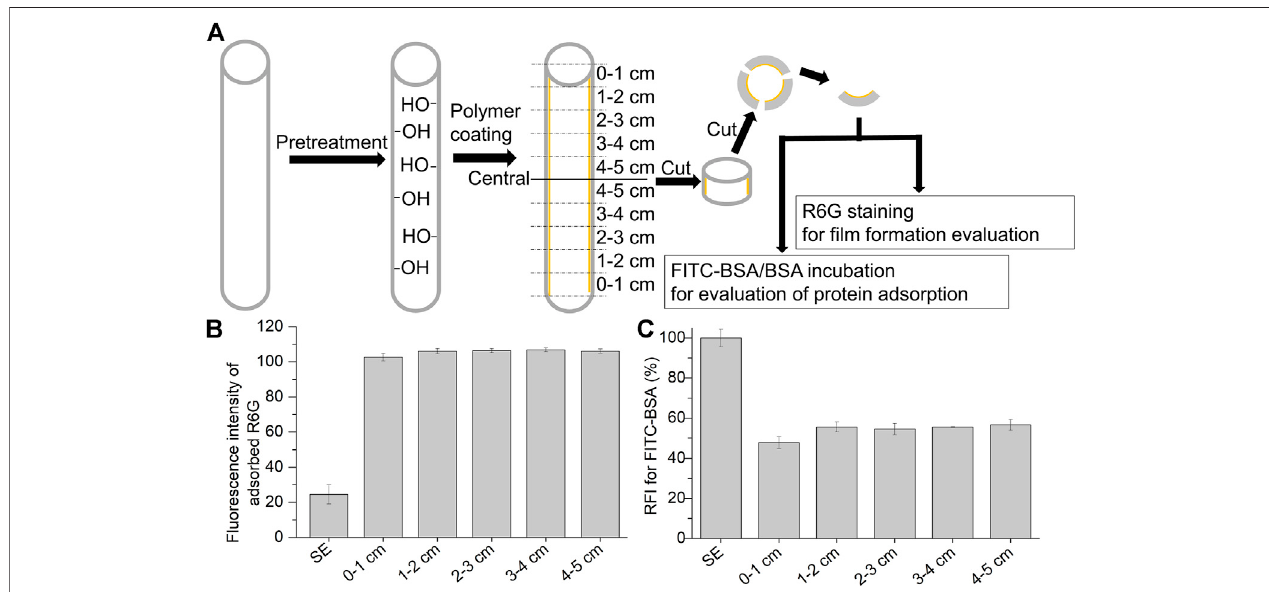
FIGURE5| Characterizationofthepolymercoatedinsiliconeelastomertube(innerdiameter:0.6 cm). (A) Procedureforthecharacterizationofthepolymer-coated tubeswithanalkalinesolution(2.5K).ThetubeswerecutintosmallpiecesbeforestainingthemwithRhodamine6G(R6G)andFITC-BSA/BSAincubation.Fluorescence intensity of the adsorbed R6G (B) and relative fl uorescence intensity of the adsorbed FITC-BSA (C) on the polymer-coated tube with alkaline pretreatment (2.5 K). Results are presented as mean ± SD ( n = 3).